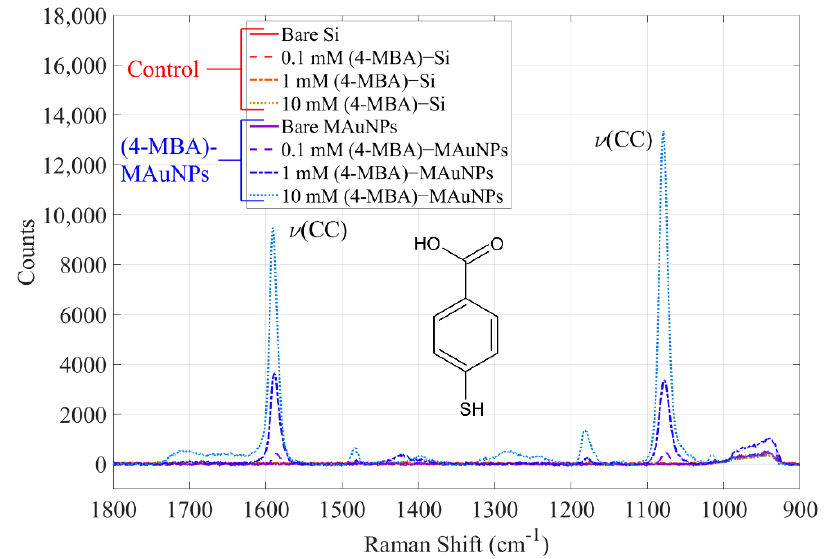
Figure 9. Raman spectra demonstrating the 4-MBA signal enhancement afforded by (4-MBA)- MAuNPs (blue) over control silicon wafers and unfunctionalized MAuNPs (red).